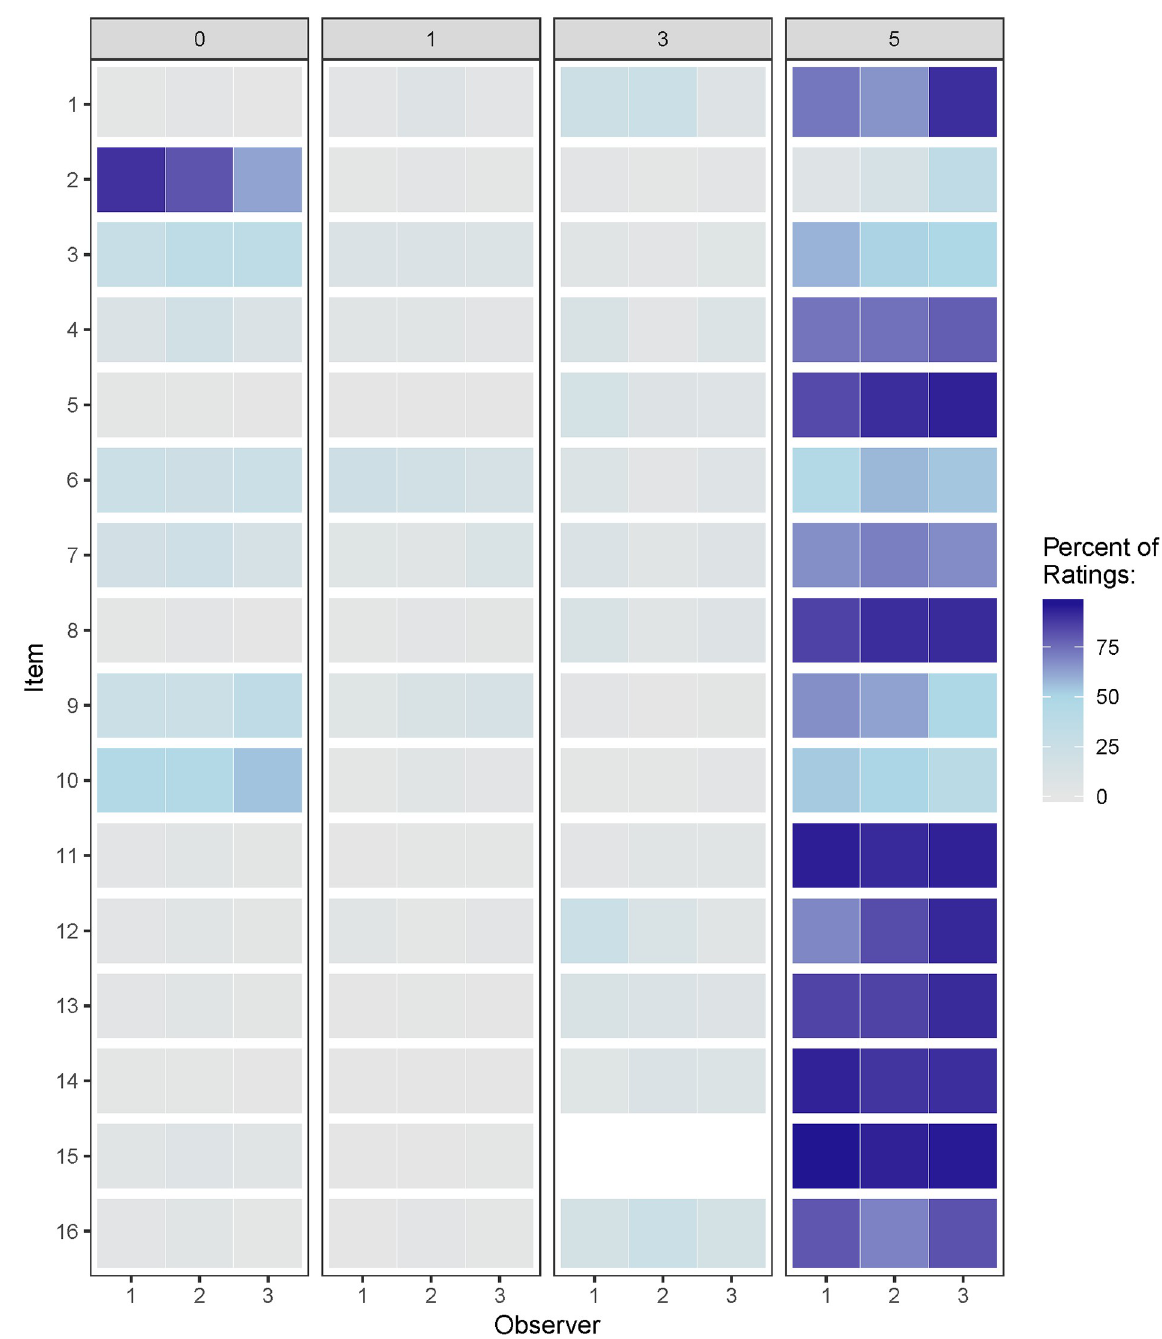
Fig 1. Heat map showing for each of the 16 items how many percent of respectively observed cases were rated “0”, “1”, “3” or “5” by each of the